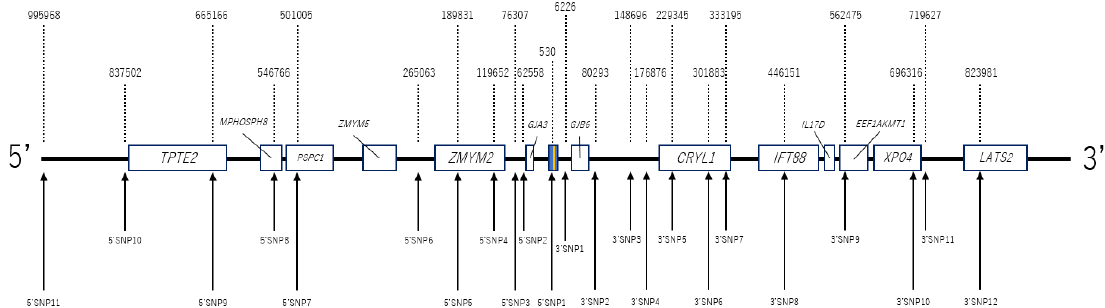
Figure 2. The location of single nucleotide polymorphisms (SNPs). Haplotypes within the 2 Mbp region surrounding the position of the most frequent mutation (c.235delC) were characterized using a set of 23 SNPs (11 sites upstream and 12 sites downstream). Tag SNPs were selected at approximately 100,000 bp intervals. For the positions with extremely biased allelic frequencies (e.g., C: 97%, T:3%), SNPs were inevitably set according to the interval. The blue rectangle in the middle indicates the GJB2 gene. The yellow line in the rectangle indicates c.235delC. Other white rectangles indicate genes around GJB2 . The numbers above the line indicate the relative distance of each SNP when c.235delC is set to 0. The numbers of the SNPs below the line correspond to the SNP numbering used in this paper.